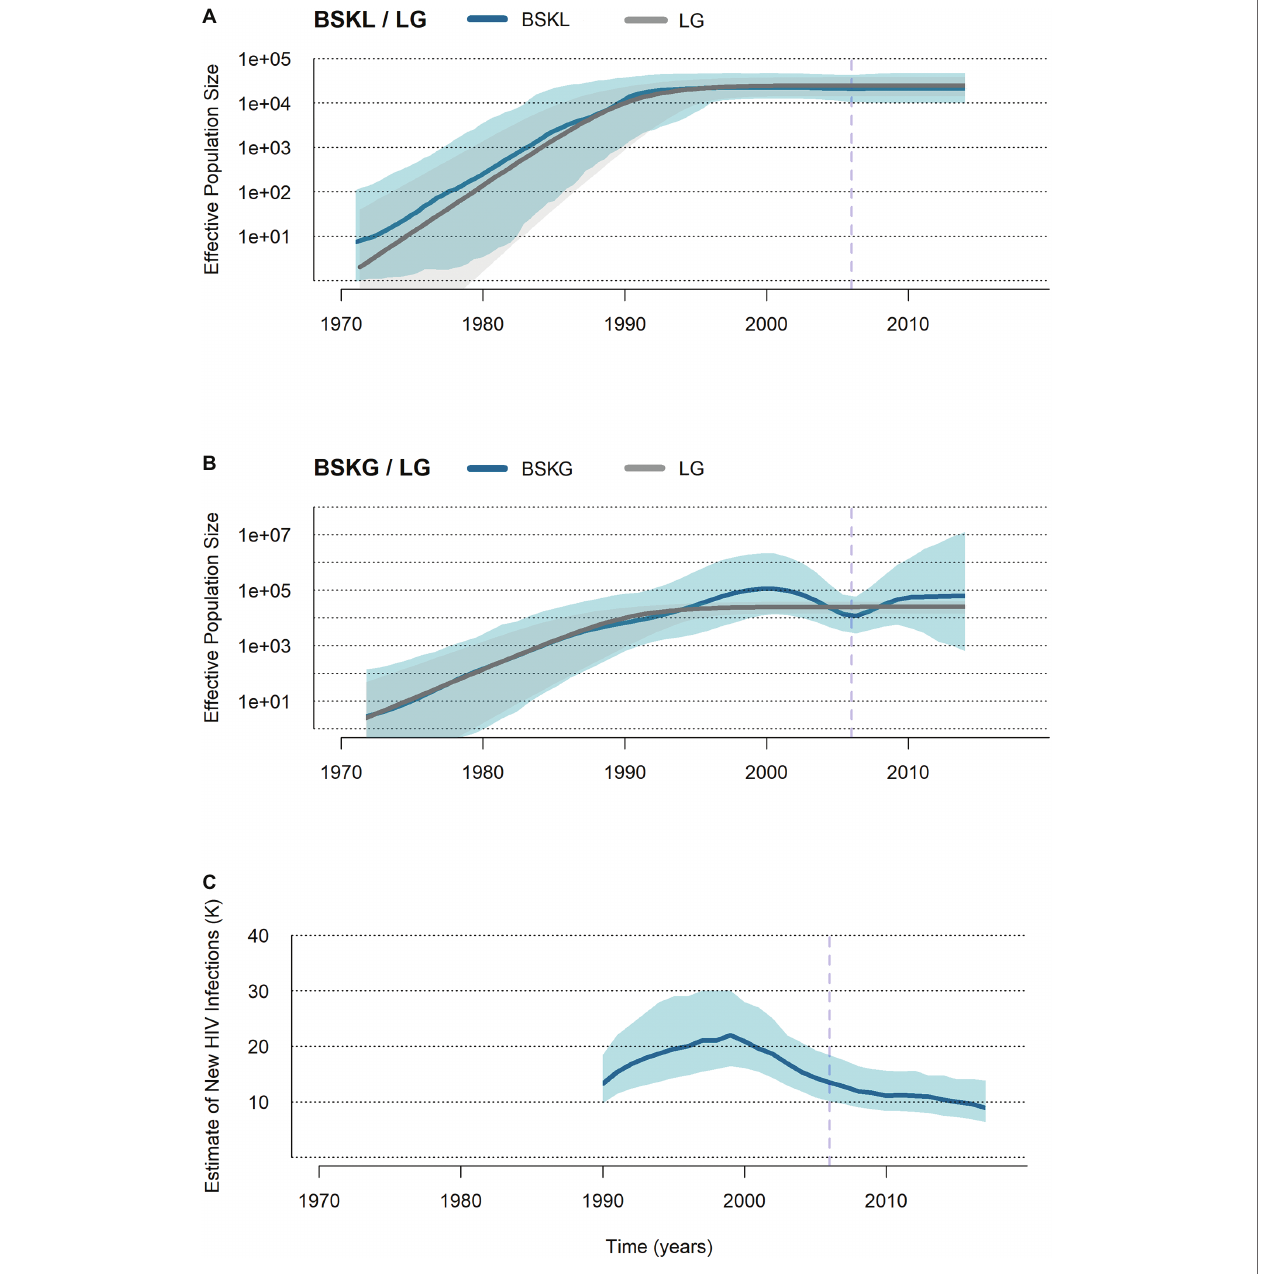
FIGURE 3 | Population and epidemiological dynamics of the HIV-1 B CAR epidemic in Hispaniola. (A,B) Plots showing the median (solid blue lines) and the 95% HPD intervals (dashed blue areas) estimates of the effective number of HIV-1 B CAR infections ( Ne , y axis) along time (years, x axis) in Hispaniola under the BSKL and BSKG models. The median Ne estimates provided by the logistic growth (LG) parametric model (dark gray line) and their 95% HPD (pale gray area) are co-plotted in both graphics. (C) Plot summarizing the number of new HIV cases in adult (>15 years old) populations from Haiti and the Dominican Republic according to the UNAIDS estimations (http://aidsinfo.unaids.org/). The dashed vertical lines indicate the time of the last coalescent